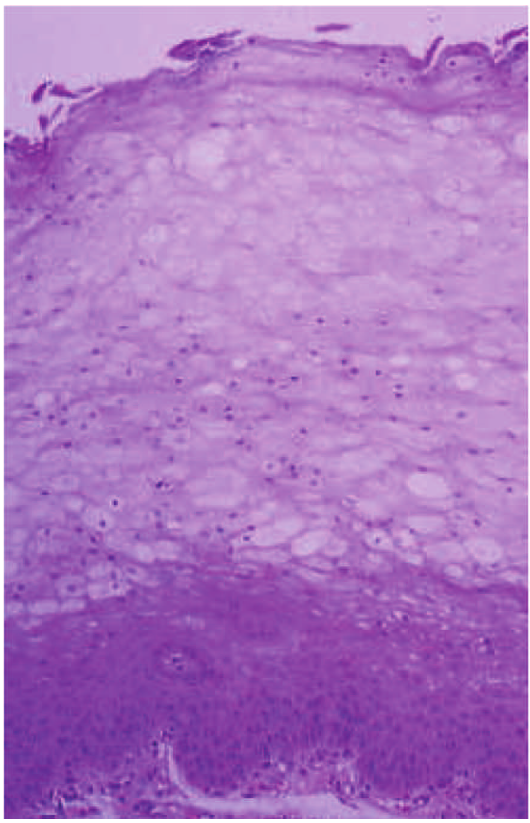
Figure 3 - Adherent white patch on right side of lateral border of tongue.